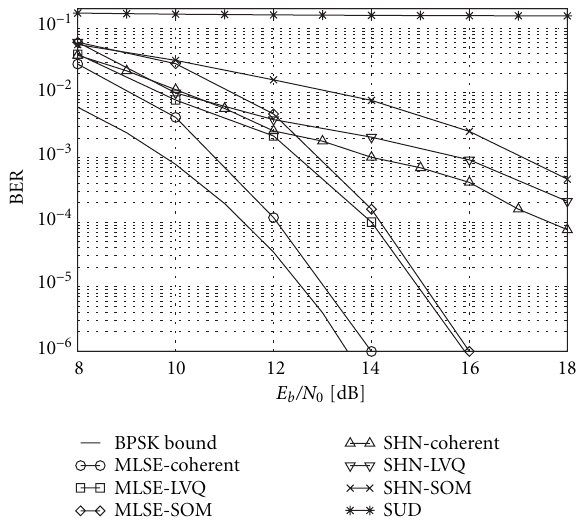
Figure 6: The synchronous case: BER versus E b /N 0 .